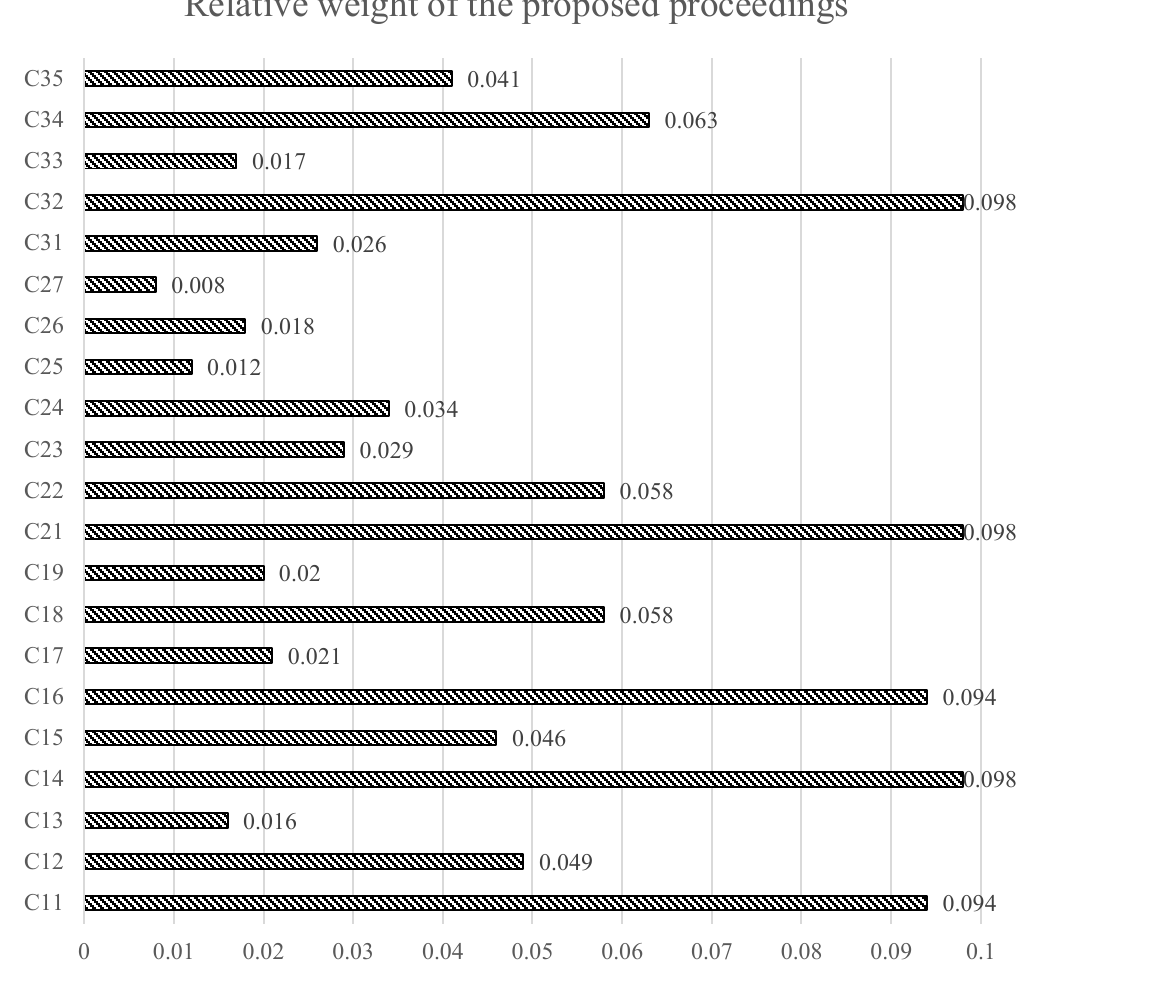
Figure 5. Preference for waste management measures proposed (overall inconsistency=0.05)